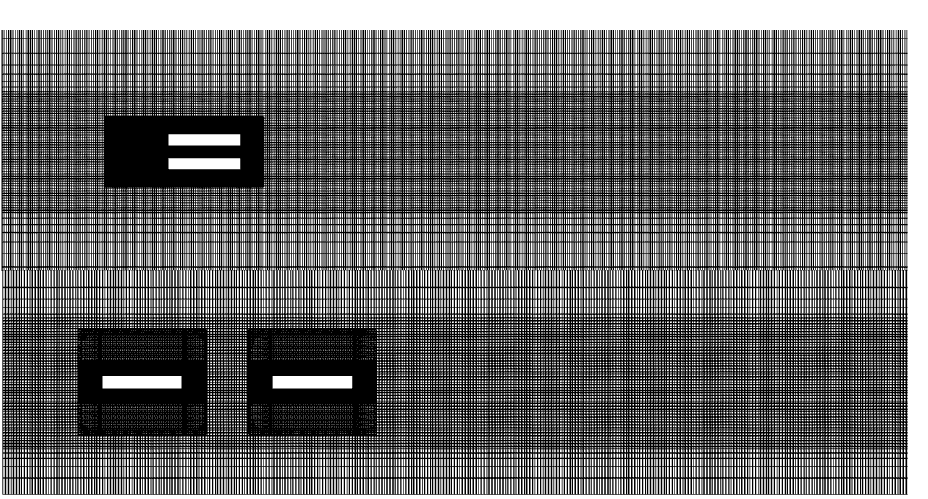
Figure 4. Schematic diagram of the two-dimensional grid in the xoy plane.